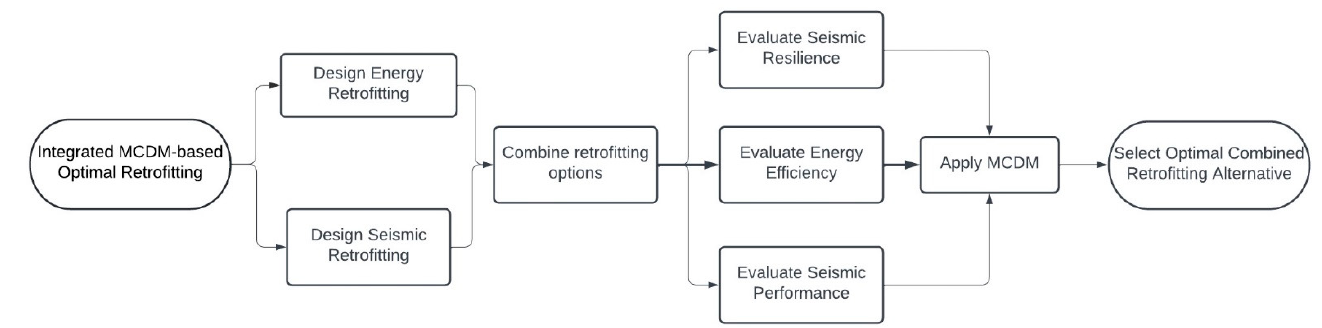
Figure 15. Integrated MCDM-based optimal retrofitting selection methodology.